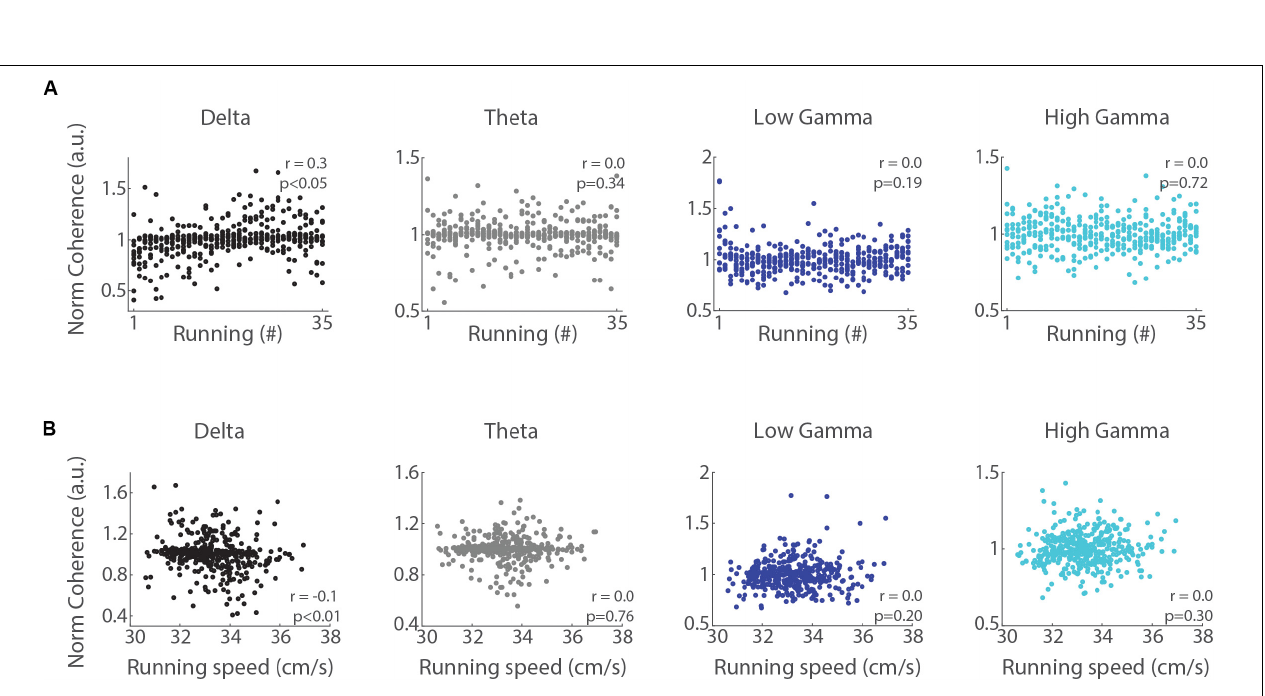
FIGURE 6 | Inter-hemispheric delta coherence correlates with the trial number. (A) Normalized inter-hemispheric coherence in the delta band during treadmill running and the trial number (“running #”) moderately and positively correlated ( r = 0.3, p < 0.05, Spearman’s correlation), while the other bands exhibited no significant relationship ( p = 0.34, p = 0.19, and p = 0.72, for theta, low gamma and high gamma, respectively, Spearman’s correlation). (B) Normalized inter-hemispheric coherence in the delta band and running speed weakly and inversely correlated ( r = –0.1, p < 0.05, Pearson’s correlation), while other bands exhibited no relationship ( p = 0.76, p = 0.20, and p = 0.30, for theta, low gamma and high gamma, respectively, Pearson’s correlation).